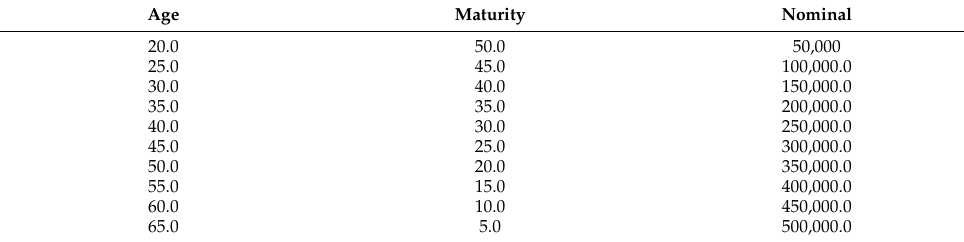
Table 1. Original portfolio for Example